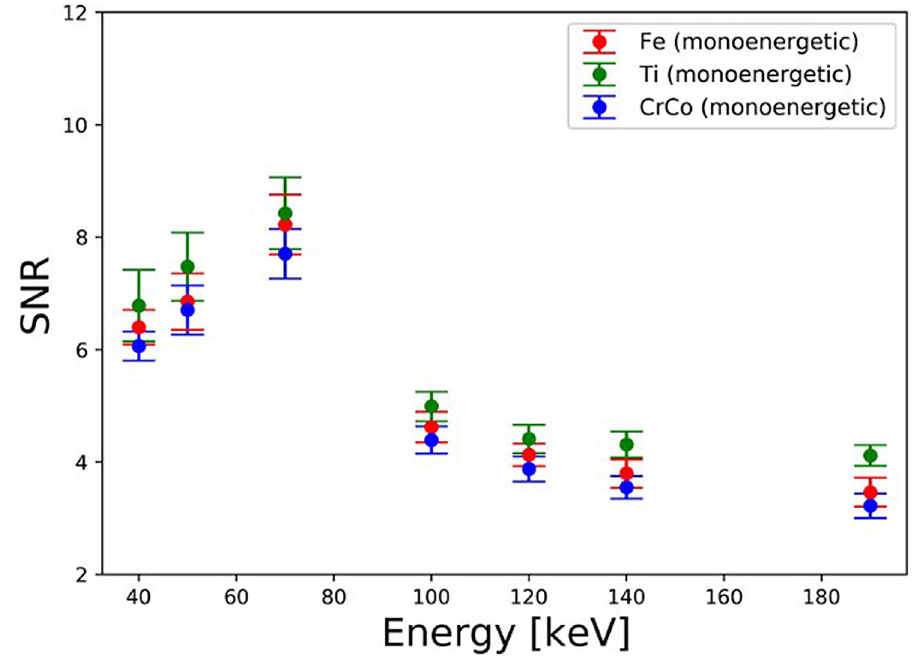
Figure 8. Image show the signal-to-noise ratio of three metal implants by different monoenergetic energies in